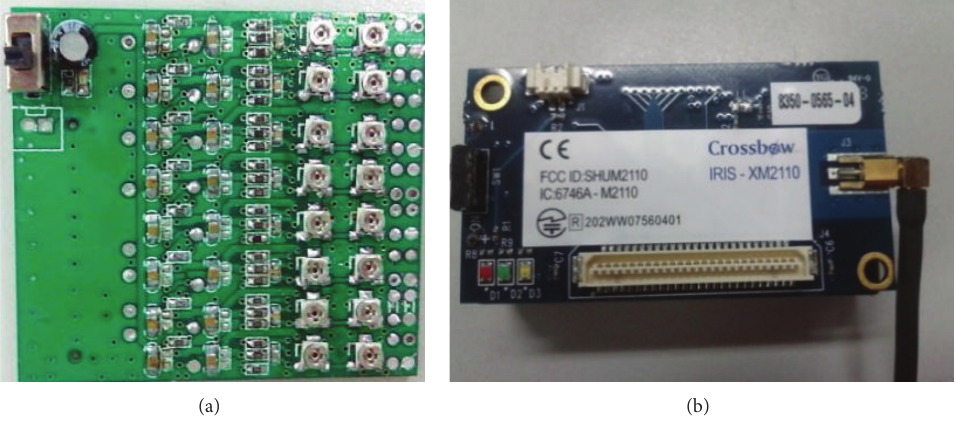
Figure 2: (a) Strain sensor board and (b) IRIS mote.